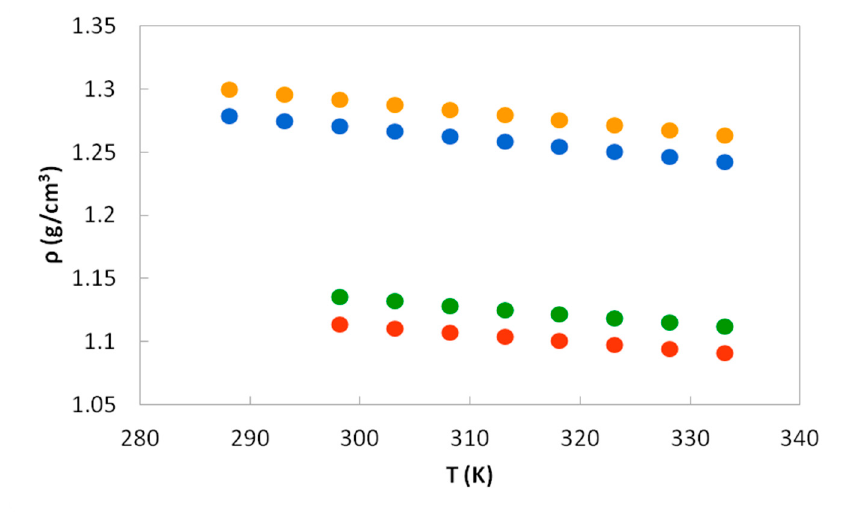
Figure 1. Density versus the temperature at 0.1 MPa, for dried ( ● ) and saturated ( ● ) [C 2 C 2 C 1 N][OTf]and dried ( ● ) and saturated ( ● ) [C 2 C 2 C 1 N][MeSO 3 ] ionic liquids (ILs).